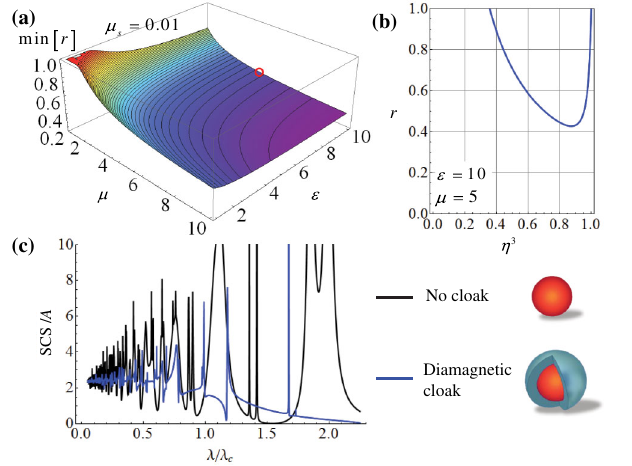
FIG. 4. (a) Evolution of the minimum attainable polarizability ratio r varying the material properties of the spherical object on which the cloak is applied. The diamagnetic cloak considered here has (cid:4) s ¼ 0 : 01 and " s ¼ 1 =(cid:4) s ¼ 100 and, for each point of the plot, the optimal filling factor (cid:5) 3 to minimize r . (b) Polarizability ratio as a function of (cid:5) 3 , for the same cloak material considered in (a) and an inner object with " ¼ 10 and (cid:4) ¼ 5 , corresponding to the red circle in (a). A minimum ratio r ¼ 0 : 43 is achieved for (cid:5) 3 ¼ 0 : 874 . (c) Corresponding normalized SCS over a broad wavelength range for uncloaked (black curve) and cloaked (blue curve) cases with optimal design, as in